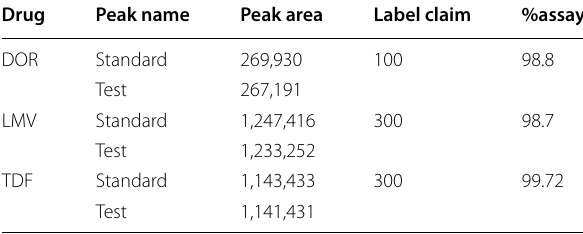
DOR Doravirine, LAM Lamivudine, TDF Tenofovir disoproxil fumarate, % percentage